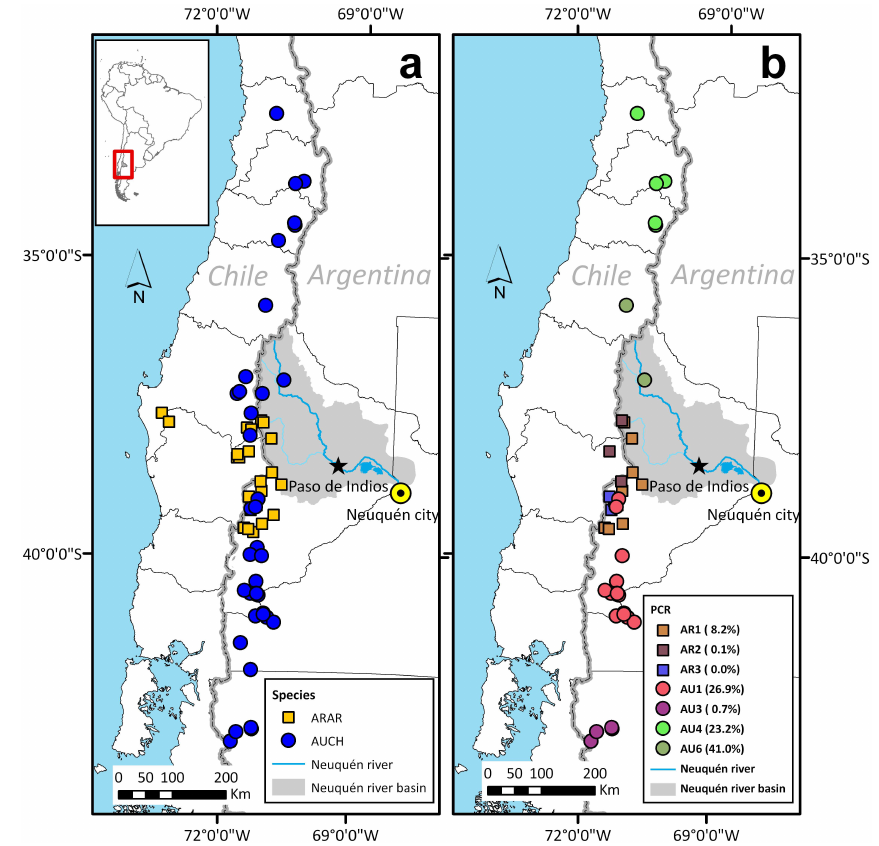
Fig. 1. Maps showing the Neuqu´en River basin (shaded area), the location of the Paso de Indios gauging station (black star), and the location of the 66 tree-ring sites initially considered as predictors (a) , and the final subset of chronologies in the reconstruction (b) . Sites are differentiated by species (a) and by beta weights of the composite chronologies over their common period 1676–2000AD (b) . The beta weights represent the explanatory power of the composite chronologies (see text for details). ARAR: Araucaria araucana ; AUCH: Austrocedrus chilensis . For composite chronologies codes, see Table 1 in the